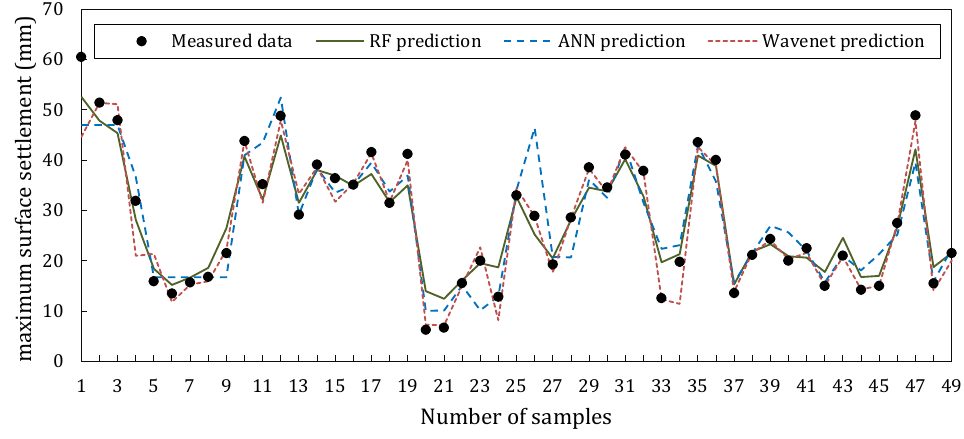
Figure 8. Comparison between measured values for MMS and predicted values using RF and ANN model for all